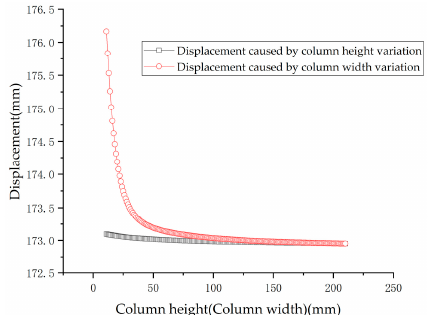
9 of 15 Figure 8. Sensitivity curve of C C plate thickness. Figure 9. Sensitivity curve of C S height and width.